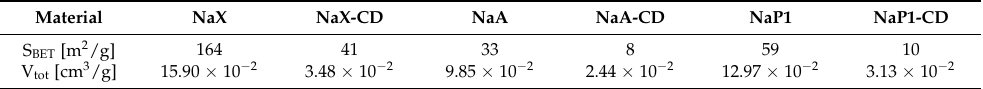
Table 3. Textural parameters of NaX, NaA and NaP1 before and after modification with β -CD.